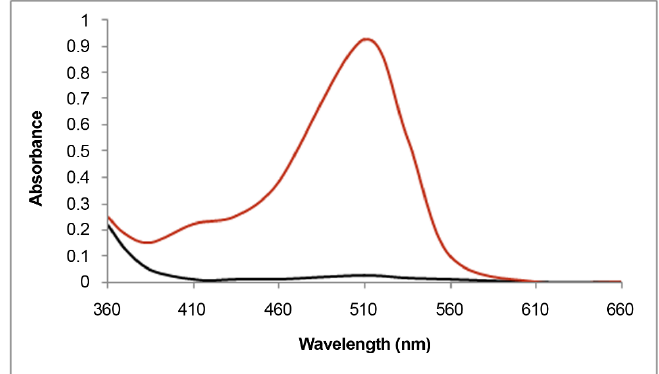
Figure 8. UV-visible absorption spectra of cyanidin-3- O - β -glucoside at pH 1.0 (red line) and pH 4.5 (black line).